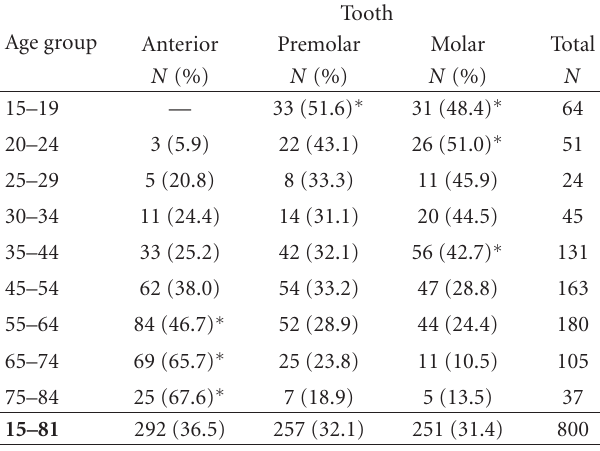
Table 4: Prevalence (%) of extractions by age group and type of teeth.